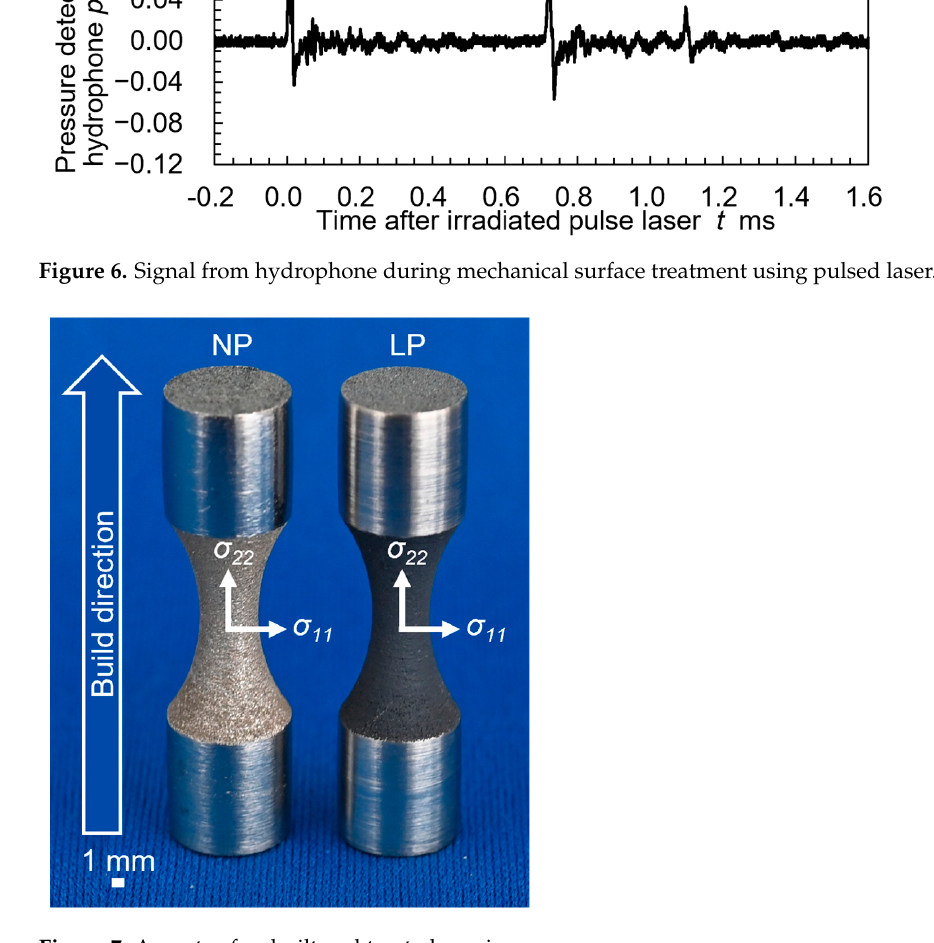
Figure 7. Aspects of as-built and treated